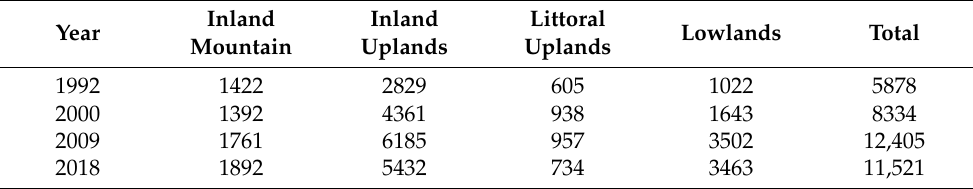
Table 2. Olive tree cultivated areas in Northern Italy (hectares) by year and elevation belt.